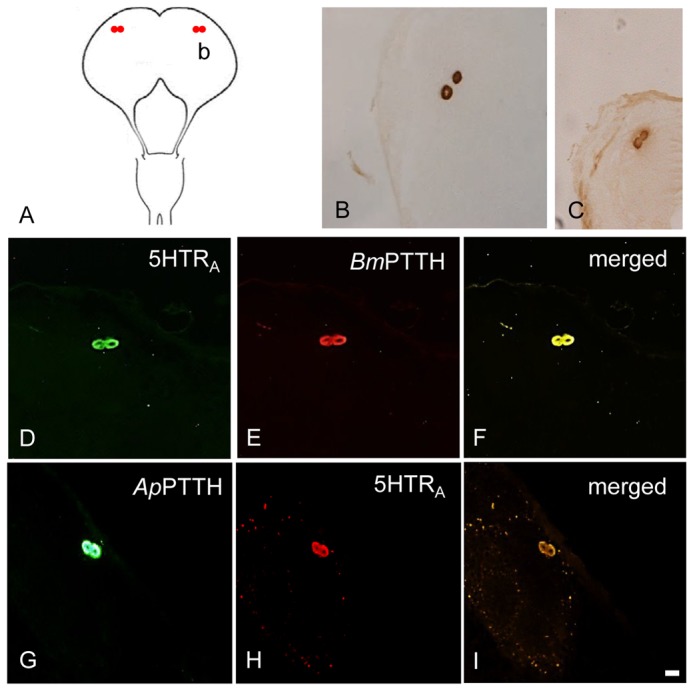
Colocalization of 5HTRA- and PTTH-ir in the early pupal BR-SOG of
A. pernyi. BmPTTH-ir/ApPTTH-ir was co-localized with Ap5HTRA-ir in the BR-SOG of 5-day-old pupa. (A) The location of detected cells. Lower-case letters correspond to the regions shown in the photographs (e.g., b to B). (B) Two large PTTH-ir neurons in the DL region. (C, D, H) Two large 5HTRA-ir neurons in the DL region. (E) BmPTTH-ir in the DL region. (F) Merged image of BmPTTH- and 5HTRA-ir in the DL region. (G) ApPTTH-ir in the DL region. (I) Merged image of ApPTTH-ir and 5HTRA-ir in the DL region. Scale bar = 100 µm.